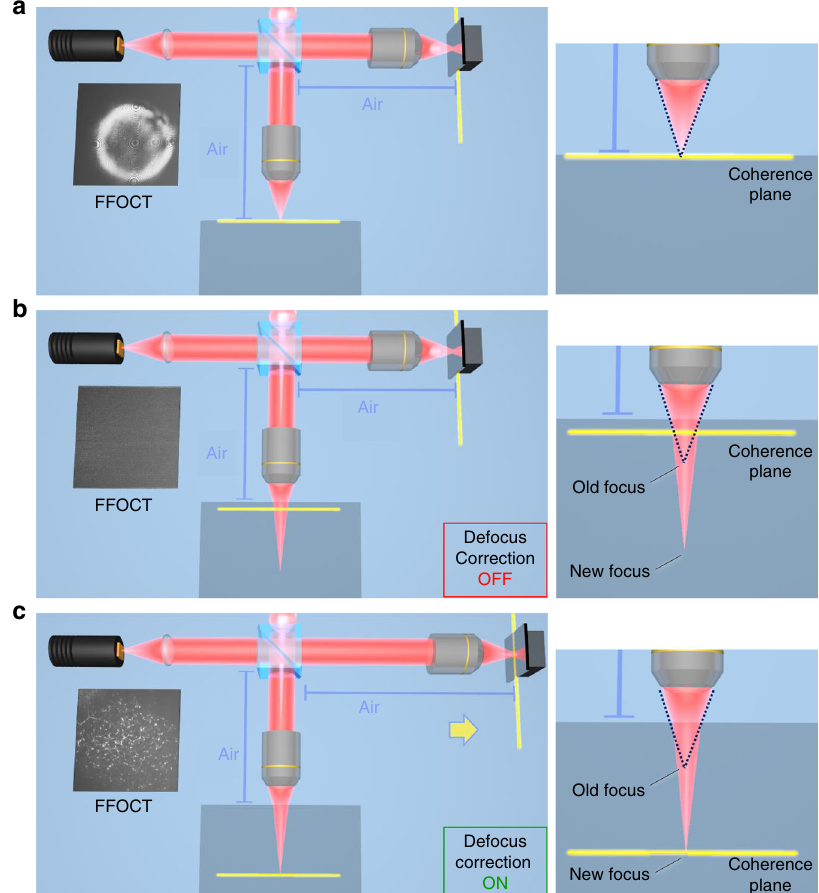
Fig. 3 Principle of defocus correction for matching the optical arms of FFOCT interferometer. a The FFOCT interferometer is focused on the surface of the sample (blue square). The focus spot matches with the coherence plane. An FFOCT image from the surface is captured and defocus correction is not needed. b FFOCT interferometer is focused inside the sample. Due to Snell ’ s law the focus is extended. At the same time the coherence plane is shifted in the opposite direction due to the higher refractive index inside the sample than in the air. The focus spot and the coherence plane are mismatched and an FFOCT image cannot be captured without defocus correction. c The FFOCT interferometer is focused inside the sample and the focus is extended. The defocus correction procedure is performed: the reference arm is extended to put the coherence plane in the new location of the focus and the FFOCT image from inside of the sample is